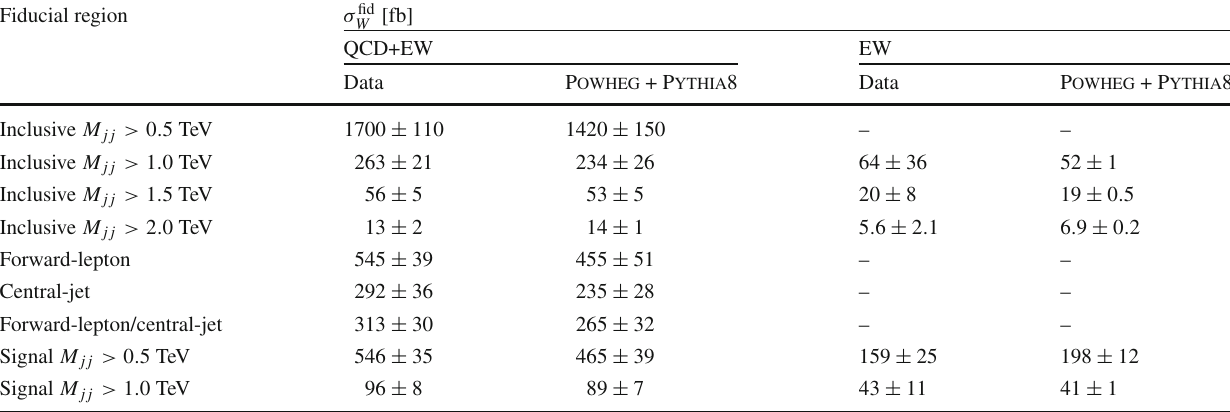
Table 7 Integrated fiducial cross sections for QCD+EW and EW W jj production and the equivalent predictions from Powheg + Pythia8 . The uncertainties displayed are the values of the statistical and systematic uncertainties added in